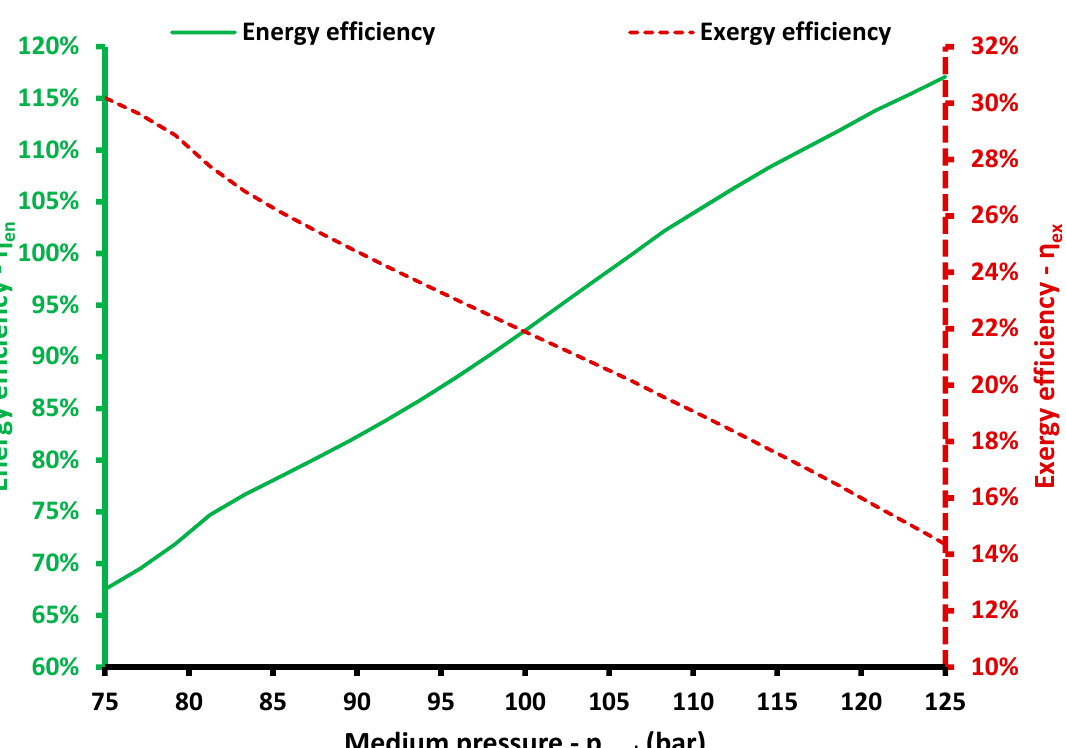
Figure 9. Energy and exergy efficiencies for different values of the medium pressure.